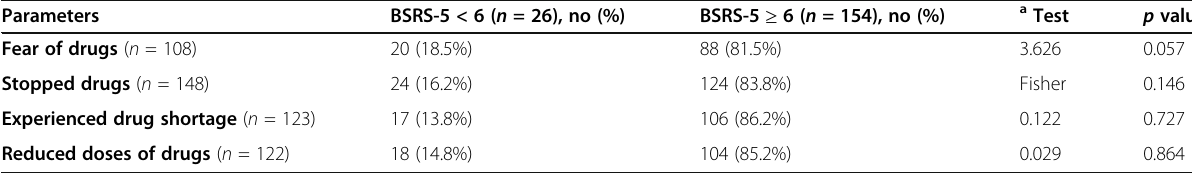
Table 6 Relation between parameters and patients mental health degree ( n = 180) (Continued)